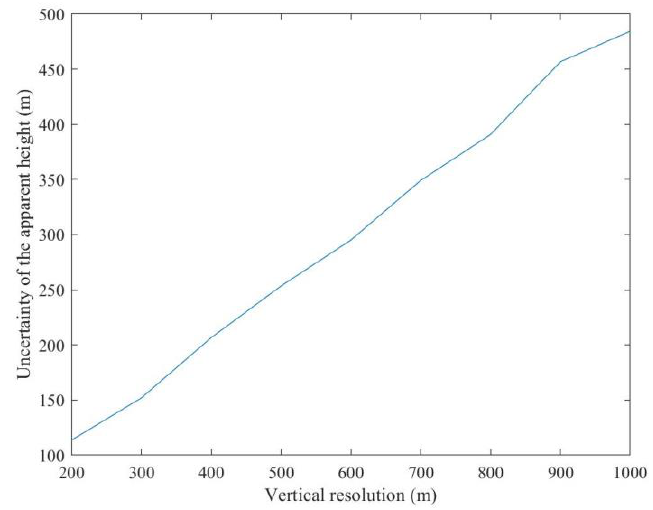
Figure 19. Uncertainty of apparent height with the vertical